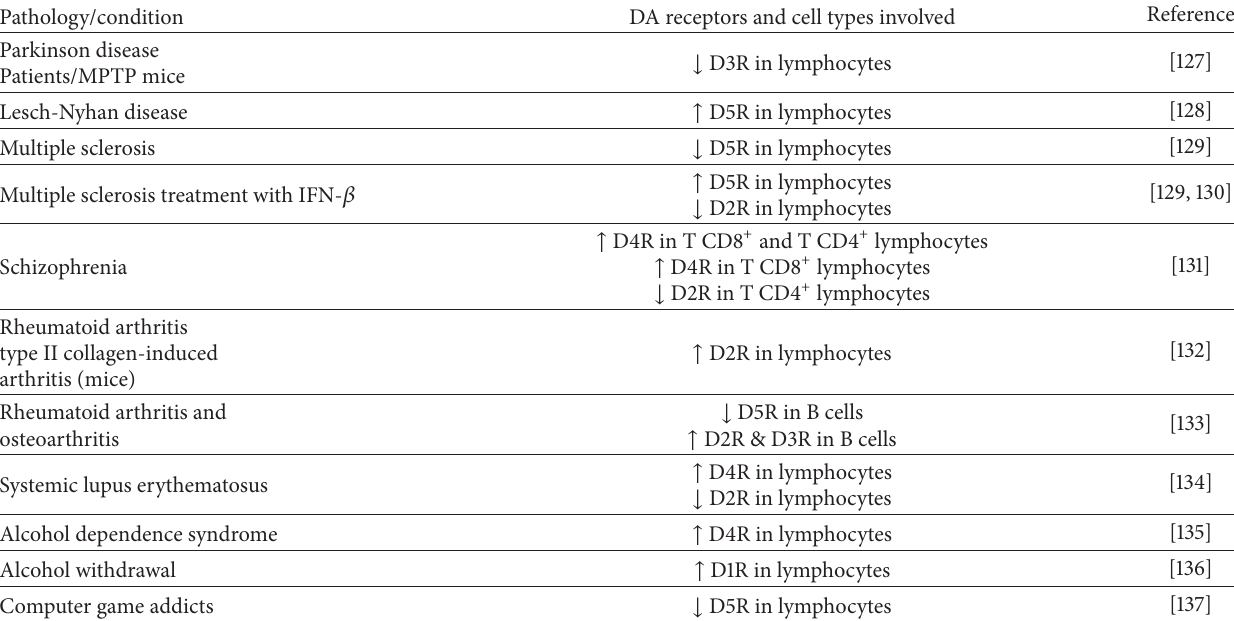
Table 4: Pathology-associated dopaminergic protein expression in immune